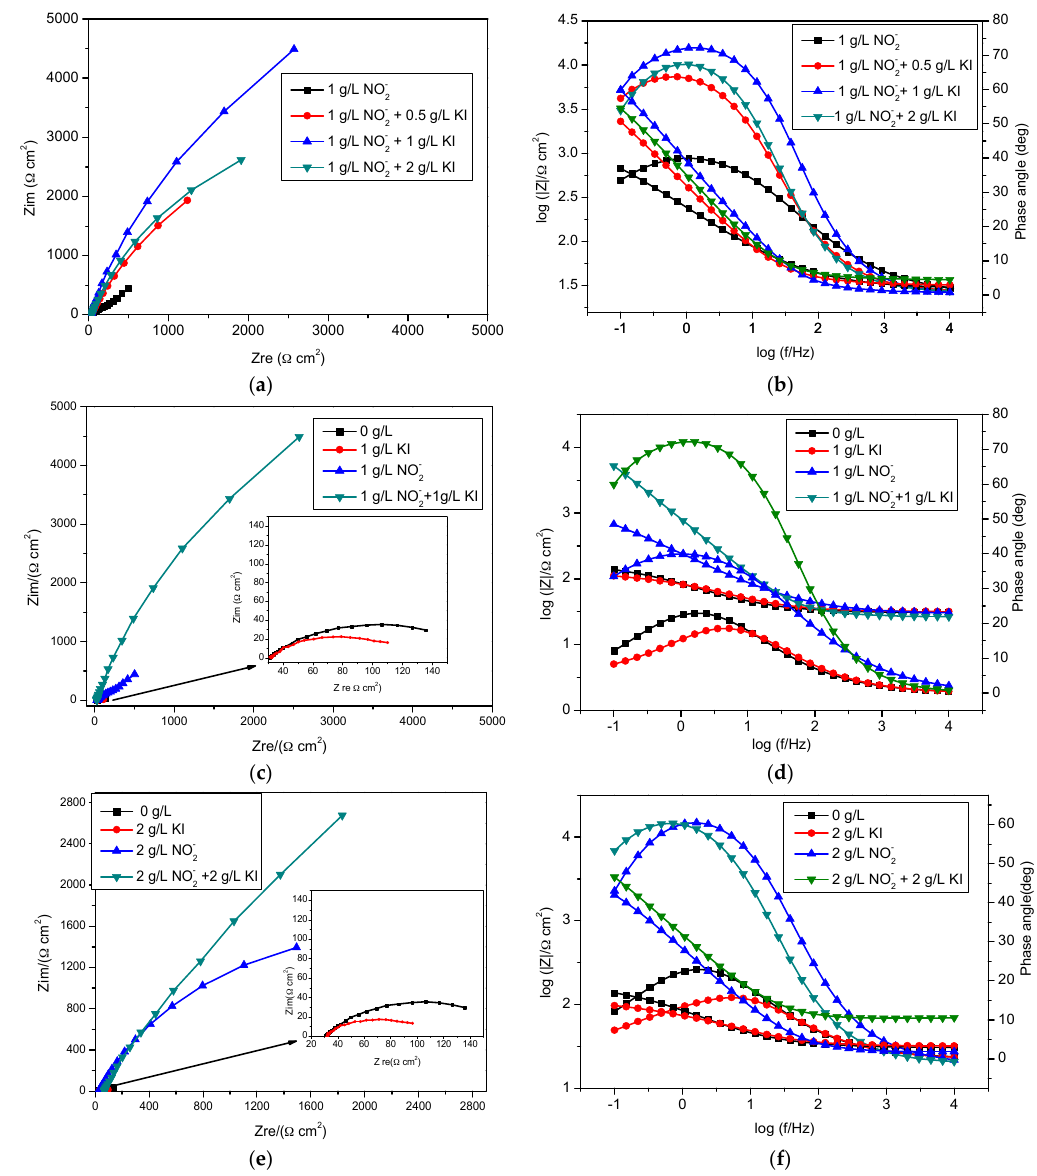
Figure 5. Impedance spectra for mild steel in bicarbonate/chloride solution at 2000 rpm at room temperature: ( a , b ) Nyquist, Bode and impedance magnitude plots in absence and presence of ( c , d ) different concentrations of KI and ( e , f ) absence and presence of KI.